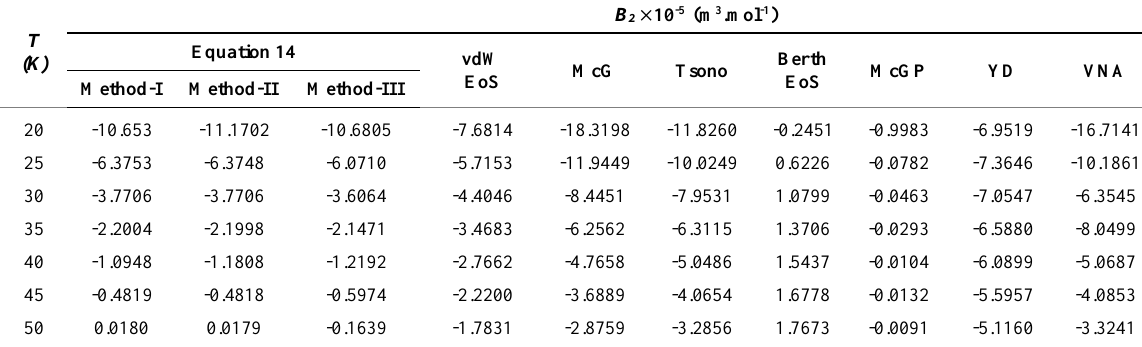
Table 4. Second virial coefficient of Orthohydrogen